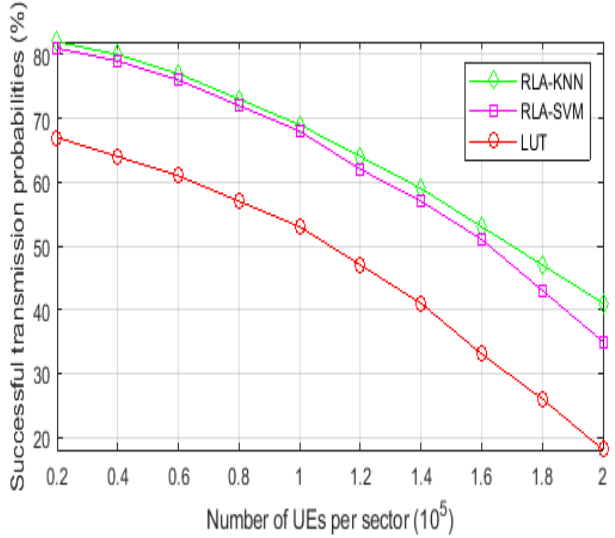
Figure 8. Probability of successful transmission according to UE numbers.